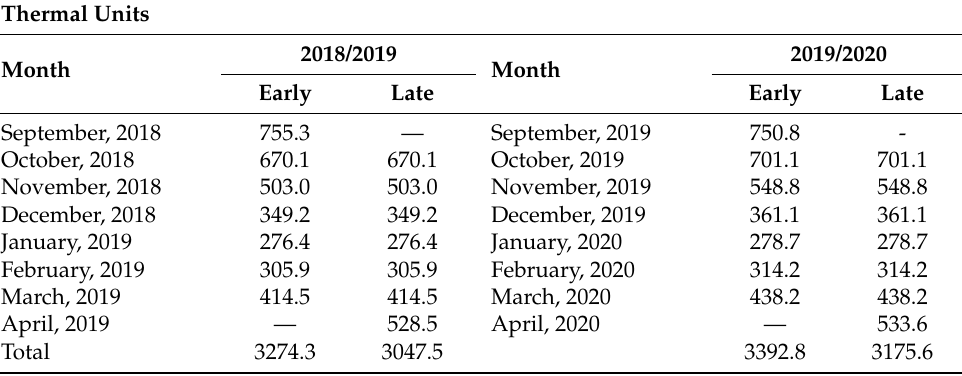
Table 2. The values of thermal units during the trial period in two growing seasons (obtained from the Fayoum meteorological